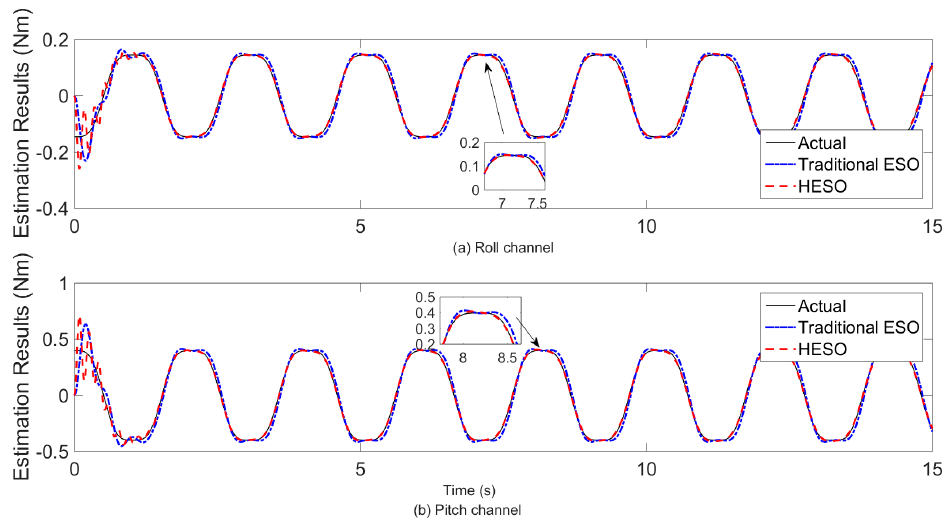
Figure 4. Simulation curves of the attitude rate in attitude stabilization: ( a ) roll channel; ( b ) pitch channel; ( c ) yaw channel.